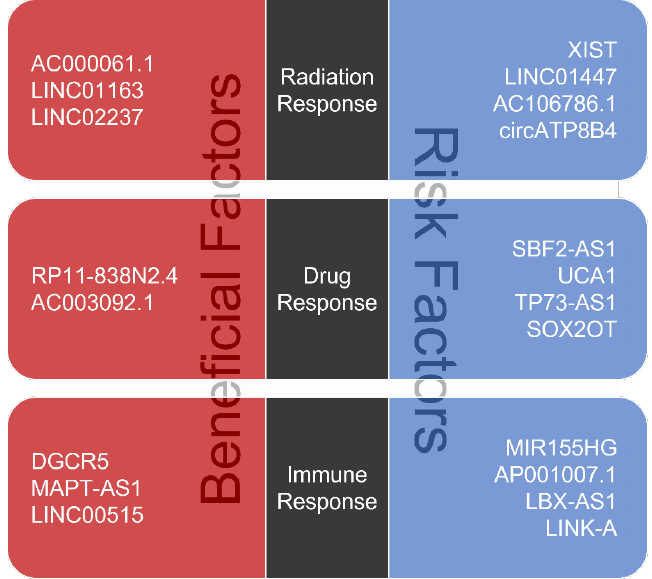
Figure 1. LncRNAs can regulate sensitivity or resistance to different types of anticancer therapies, including radiotherapy, chemotherapy and immunotherapy. LncRNAs associated with increasing therapeutic sensitivity act as beneficial factors and must be upregulated to improve efficacy of glioma treatments. On the other hand, lncRNAs associated with increasing therapeutic resistance act as risk factors and must be downregulated.